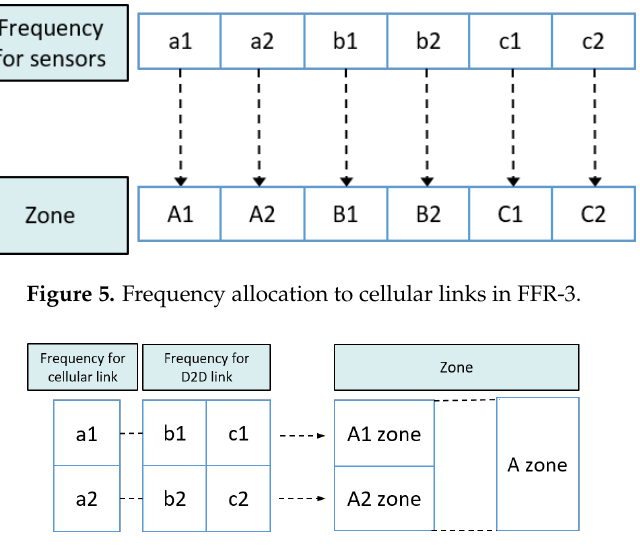
Figure 6. Frequency allocation to cellular link and D2D link.